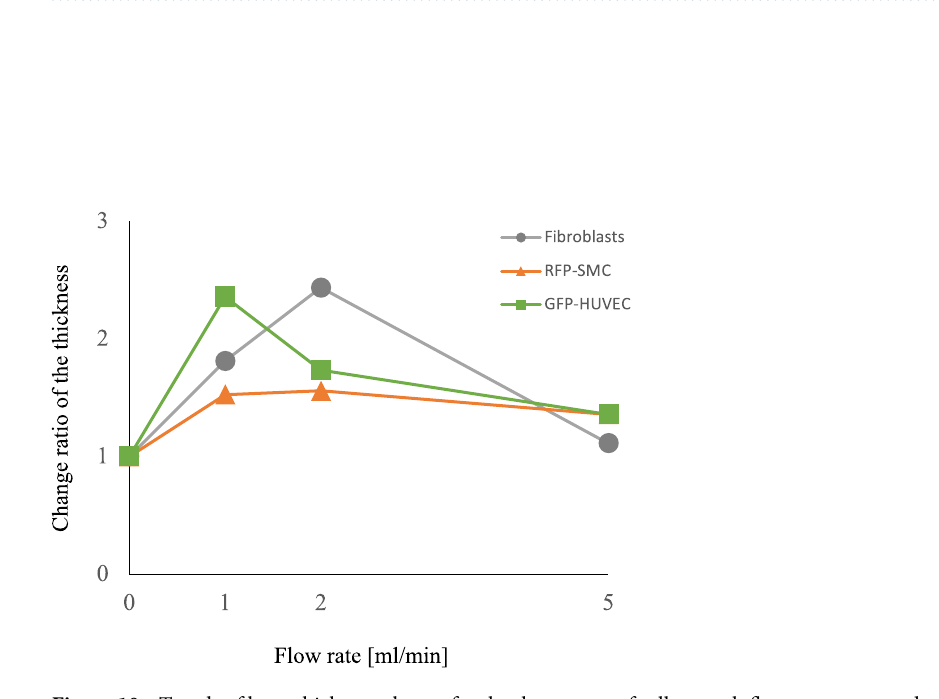
Figure 10. Trends of layer thickness change for the three types of cells at each flow rate compared with static